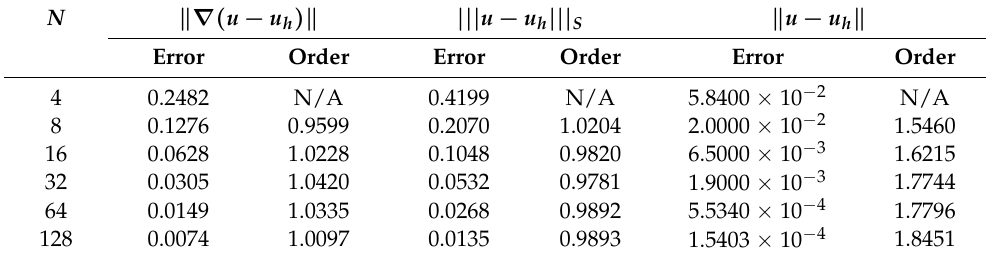
Table 2. Experiment results for the exact solution u = x 2 + y 2 with B.C. II.